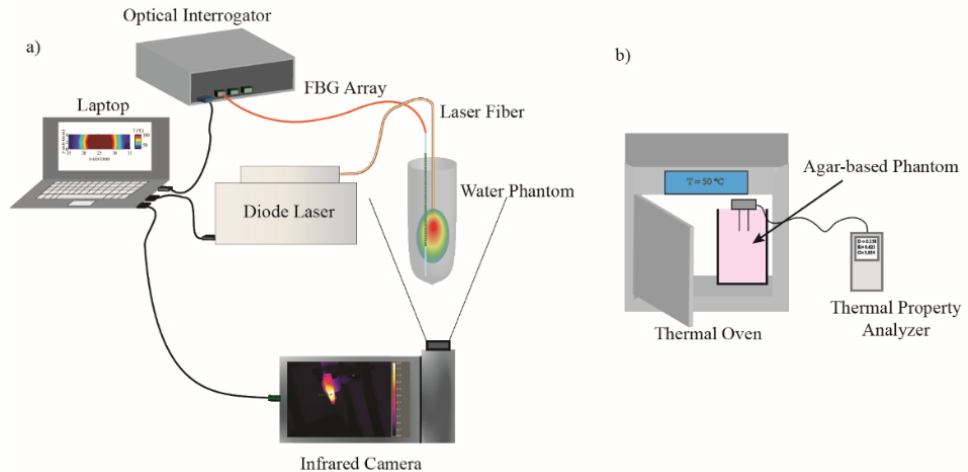
Figure 2. Experimental set up for ( a ) evaluation of NPs photothermal response and ( b ) measurement of NPs thermal properties.